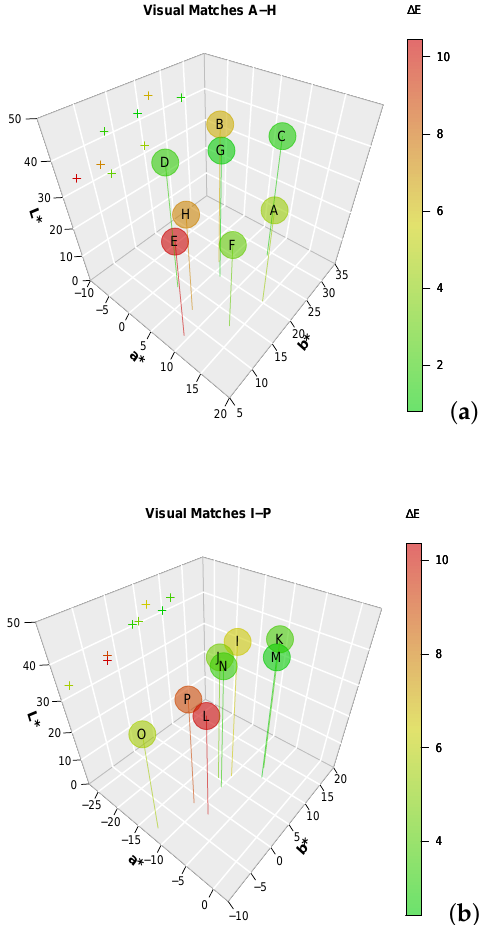
Figure 8. Visual matching results for red-brown samples A–H ( a ) and green-blue samples I–P ( b ). Each point represents the position of the weighted visual averages in L*a*b* space, with its colour indicating the colour difference ∆ E to the corresponding computed matches. The visual averages are also projected onto the (L*,b*) plane for